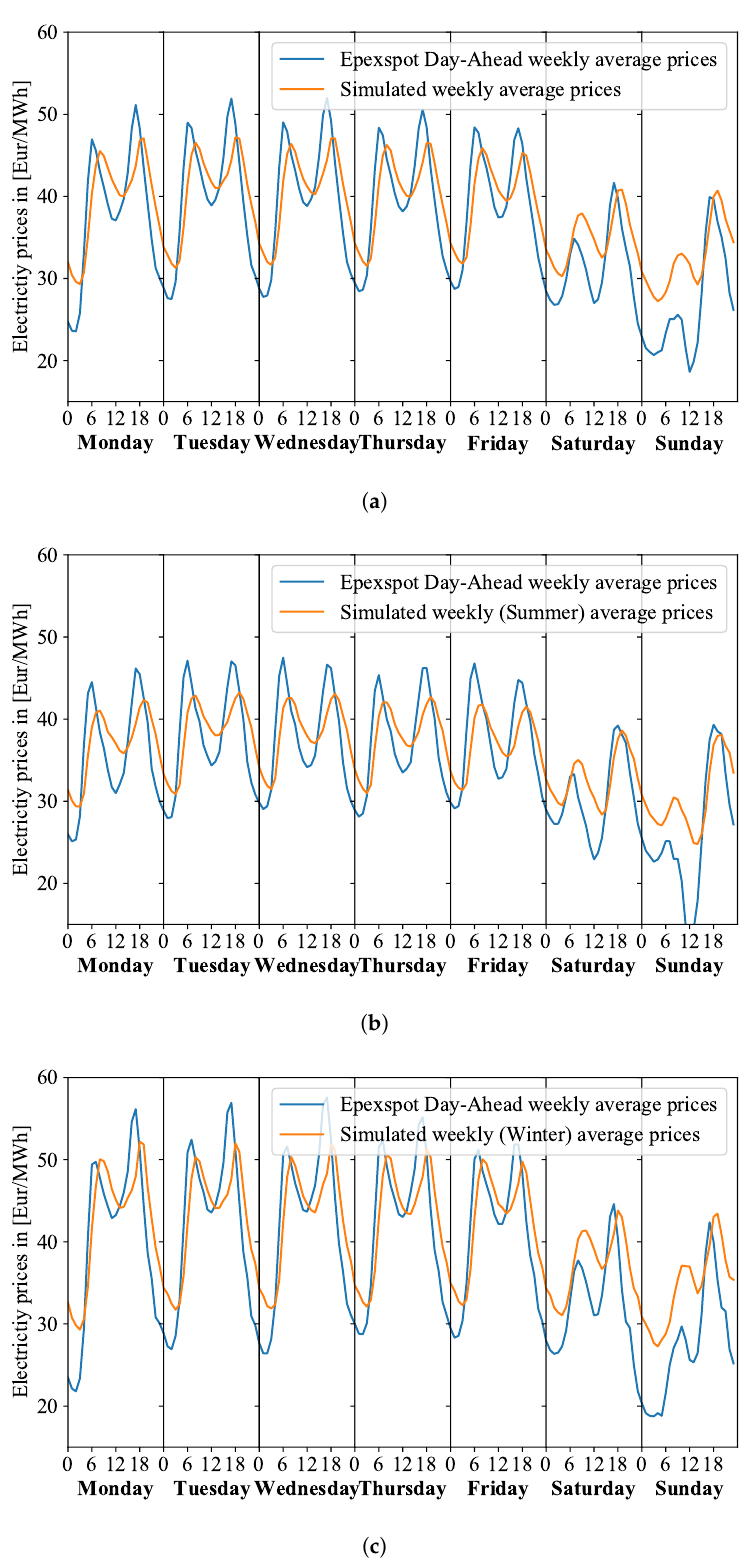
Figure 5. Weekly averaged historical and simulated prices. ( a ) Total simulation period; ( b ) Summer weeks; ( c ) Winter